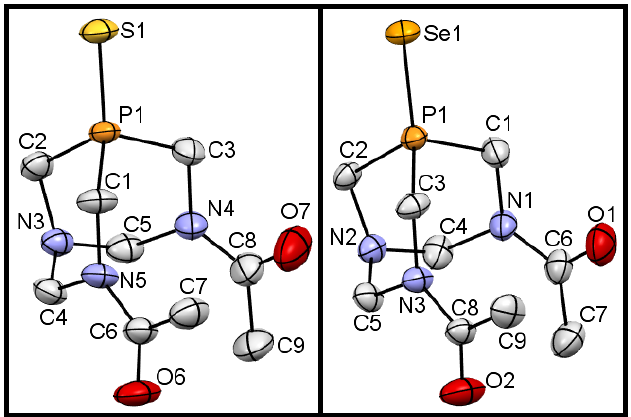
Figure 4. 1 H NMR spectra of DAPTA and compounds 1 – 3 in DMSO- d 6 .